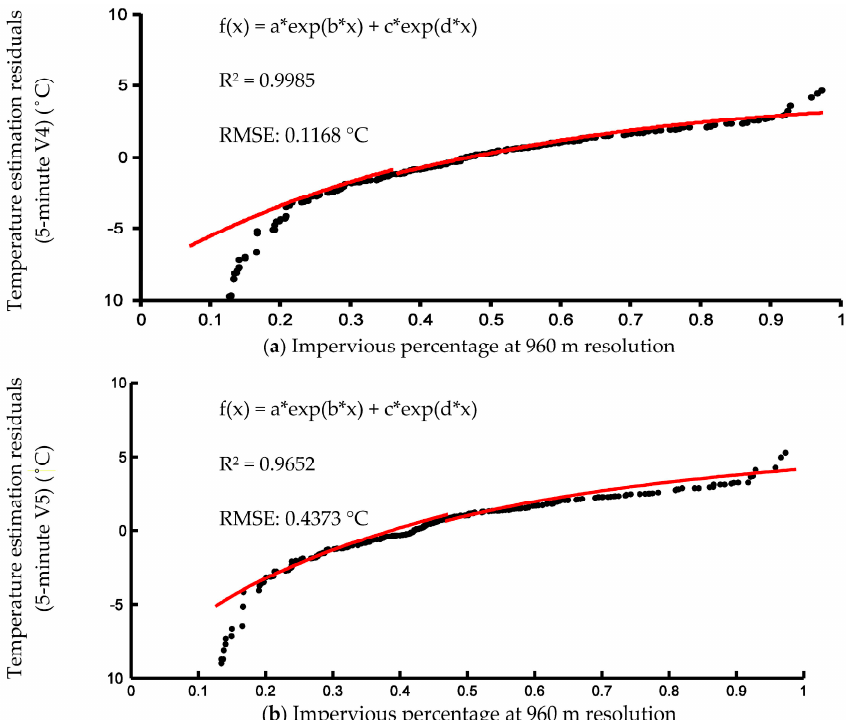
Figure 7. Exponential fit model between impervious percentage index and temperature estimation residuals calculated using the original DisTrad based on impervious percentage [26,29] applied to MODIS 5-min land surface temperature products ( a ) V4 and ( b ) V5 at low resolution of 960 m.